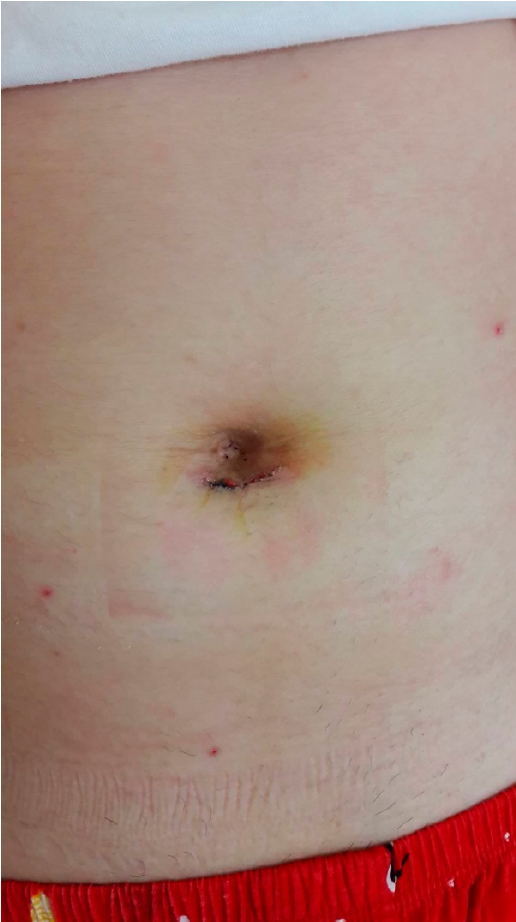
Figure 4. The wound condition during outpatient department